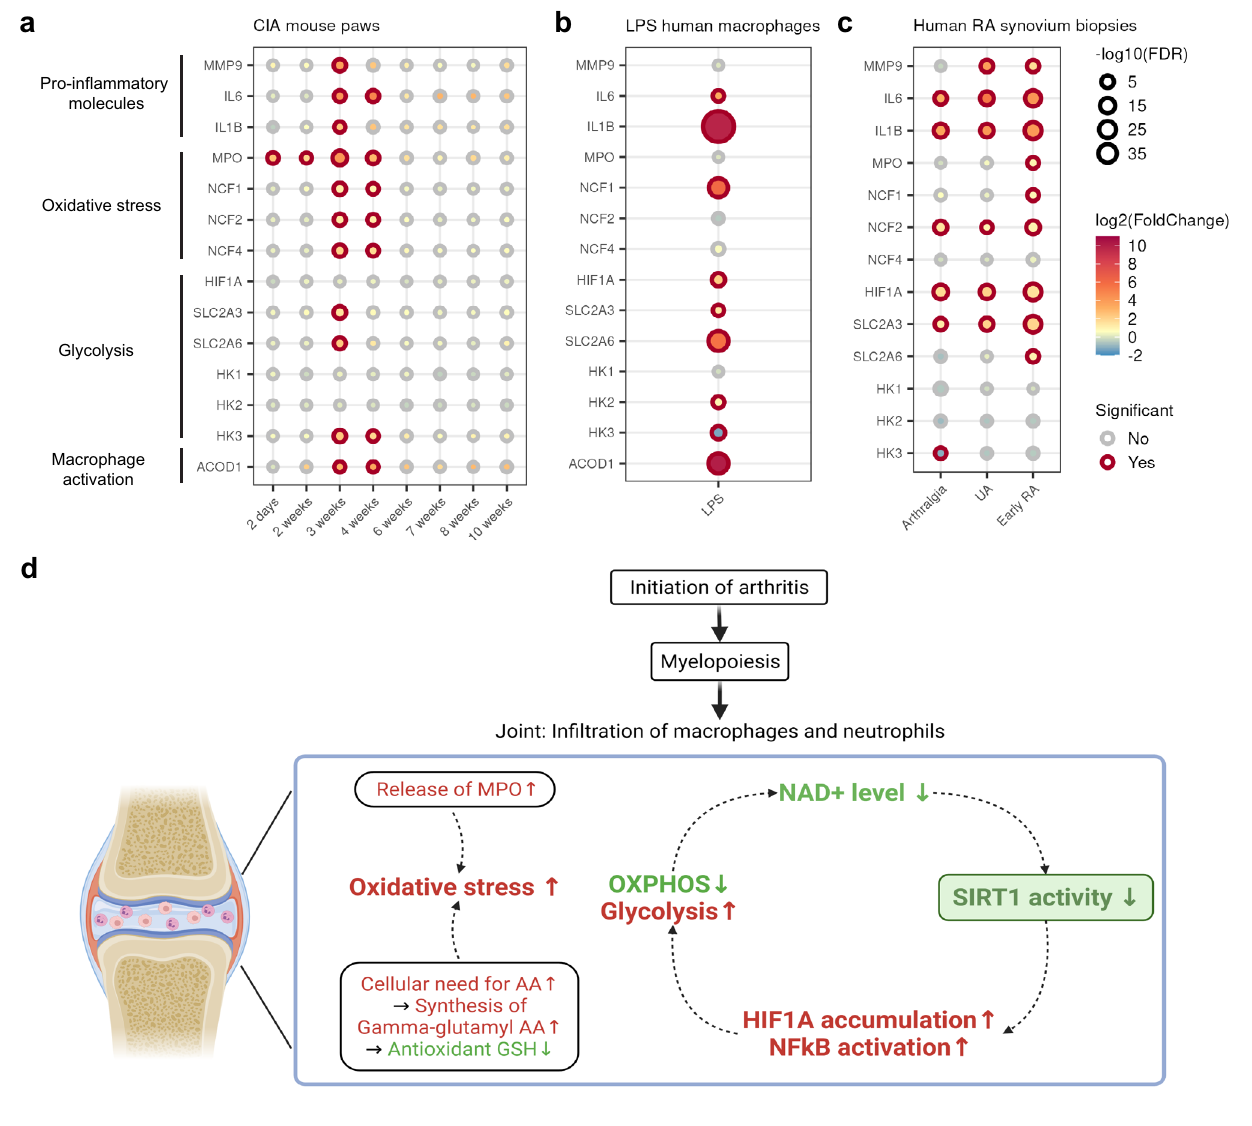
Figure 8. Metabolic reprogramming in early RA. ( a–c ) Differential gene expression of major metabolic genes in the RNA-seq studies of CIA mouse paws, LPS-stimulated human macrophages, and human RA synovium biopsies. Significance was decided by cutoffs of FDR < 0.05 and fold change > 1.5 in up or down direction. ( d ) Schematic hypothesis showing that innate immune cells drive the metabolic changes by SIRT1 axis at the initial phase of